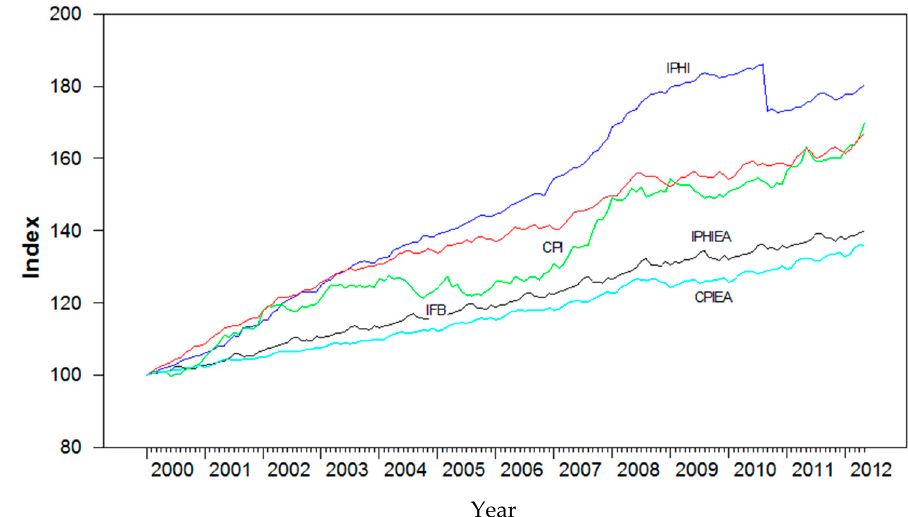
Figure 1. Price indices in levels (base period January 2000). Data vector January 2000 to May 2012 (Great Depression).